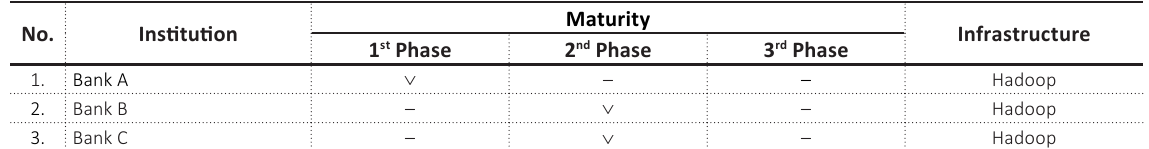
Table 2. Implementation of big data